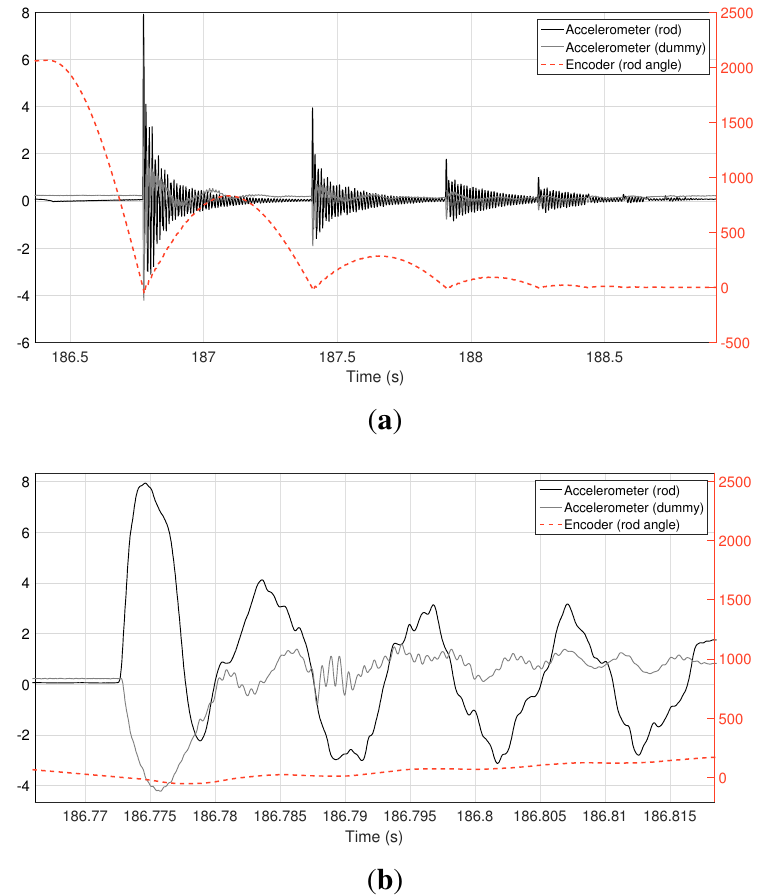
Figure 9. ( a ) Overview and ( b ) close-up of the collision test. Left-hand vertical axis represents voltage for accelerometer readings (after signal conditioning), whereas the right-hand axis stands for pulse counts for the encoder attached to the rod